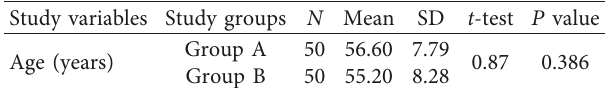
Table 2: The mean differences of age between study groups.